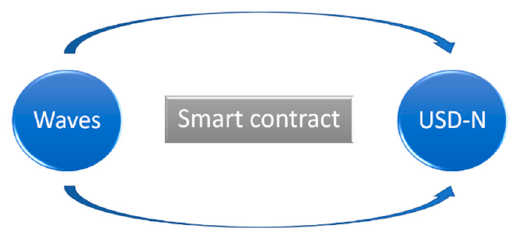
Figure 1. Example of a swap between waves and Neutrino USD (USD-N).